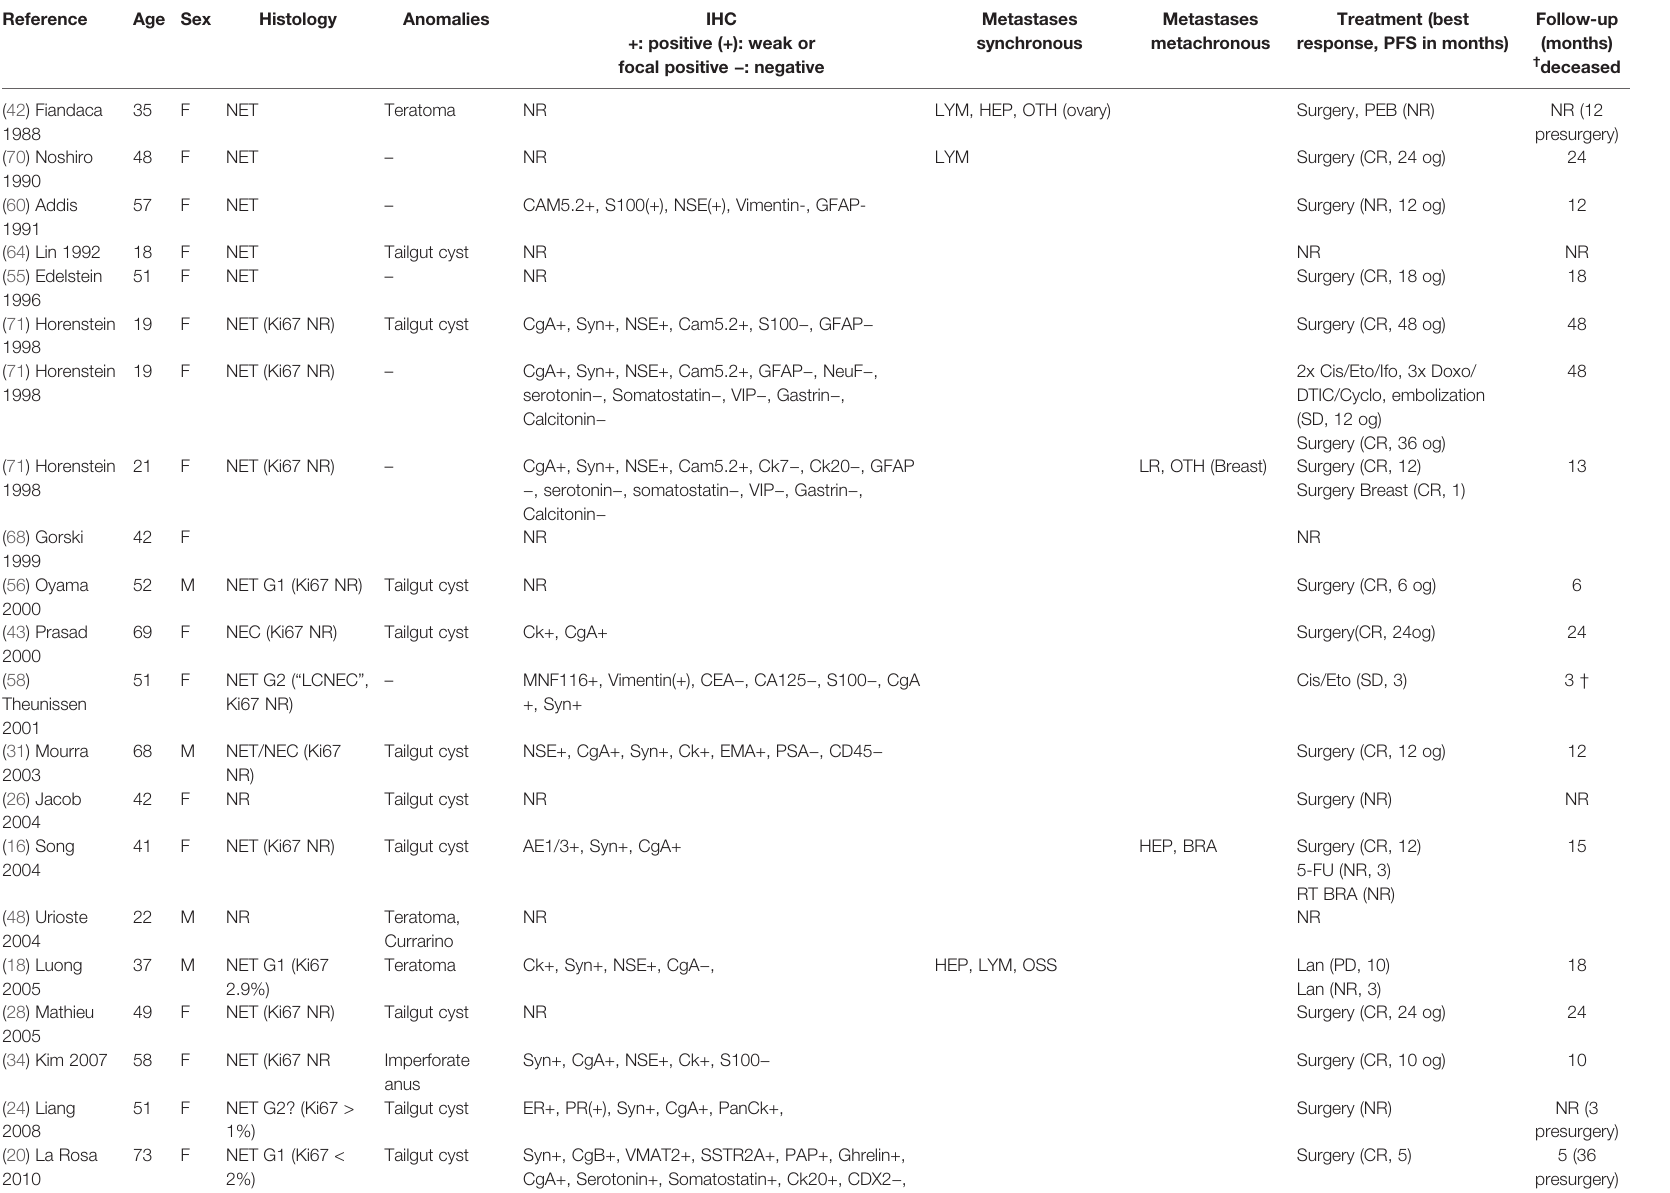
TABLE 3 | Previously reported cases of presacral